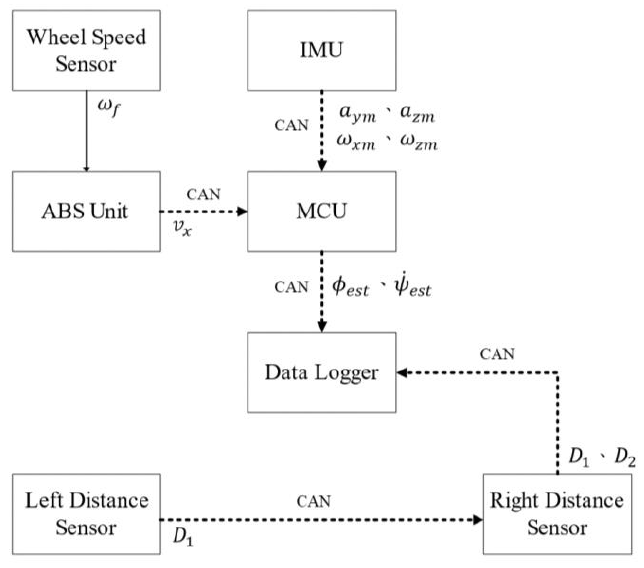
Figure 5. Experimental scheme. The true value for the roll angle was calculated using the distance signals from the laser sensors that were mounted on both sides of the rear wheel, as shown in Figure 6. Equation (36) was used to calculate the roll angle based on data from the laser sensors.